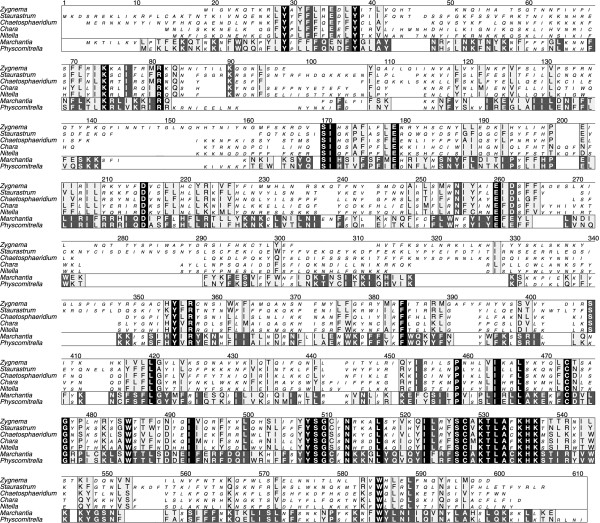
Sequence conservation among streptophyte MatK proteins. The MatK sequences of selected green algae and land plants were aligned with T-COFFEE [40] and arranged into two separate groups. Identical amino acids in all the sequences examined are displayed on a black background, whereas identical amino acids in all the green algal or land plant sequences are shown on a dark grey background. In each group, sets of residues sharing eight of the 10 features in the property matrix of AMAS [41] are shown on a light grey background. The accession numbers for the MatK sequences analyzed are as follows: Zygnema, [GenBank:AY958086]; Staurastrum, [GenBank:AY958085]; Chaetosphaeridium, [GenBank:NC_004115]; Chara connivens, [GenBank:AY170442]; Nitella opaca, [GenBank:AY170449]; Marchantia, [GenBank:NC_001319]; and Physcomitrella patens [GenBank:NC_005087].